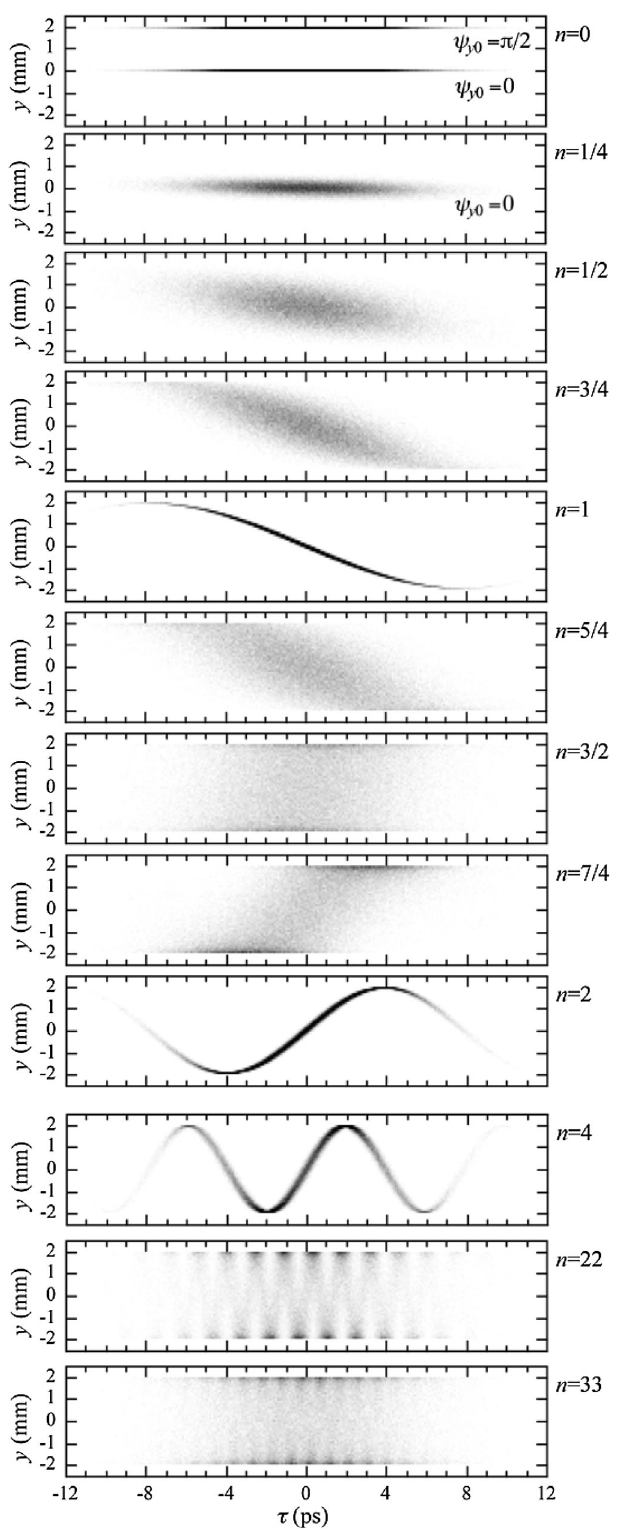
FIG. 2. Typical spatial bunch structures in the (cid:4) - y plane. Two images at n ¼ 0 show structures at two betatron phases. Both the longitudinal radiation excitation as well as damping were con- sidered. The contributions of the horizontal movement and the nonlinear effect were not